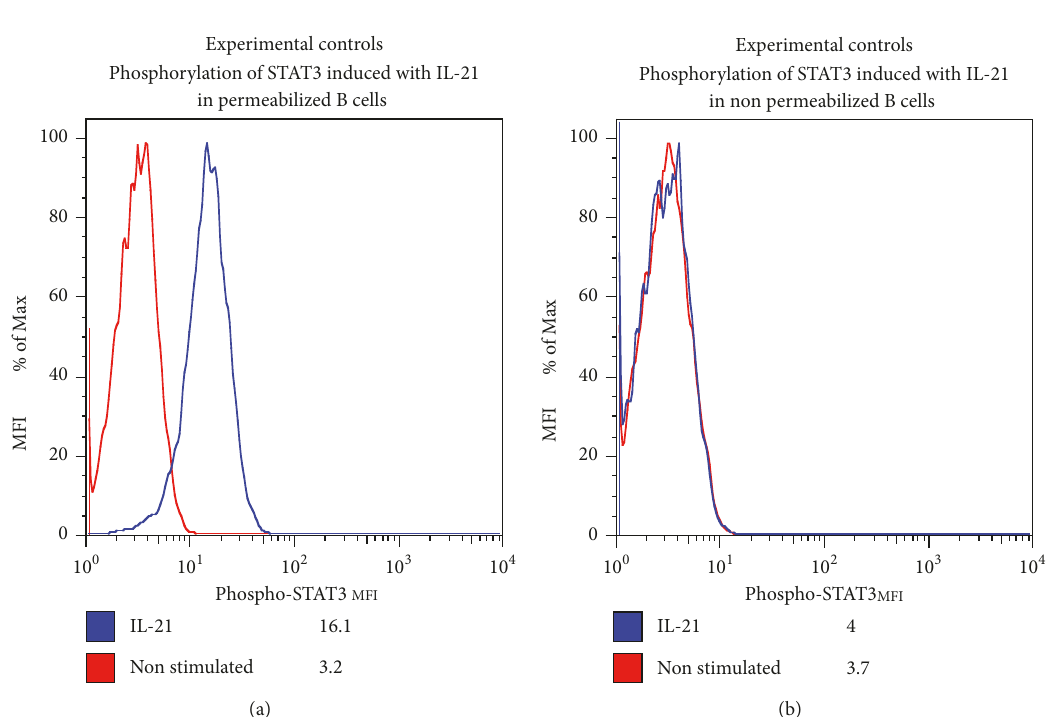
Figure 5: The patient showed low phosphorylation of STAT3 after 15 minutes of stimulation with rhIL-21; this image shows the comparison with experimental